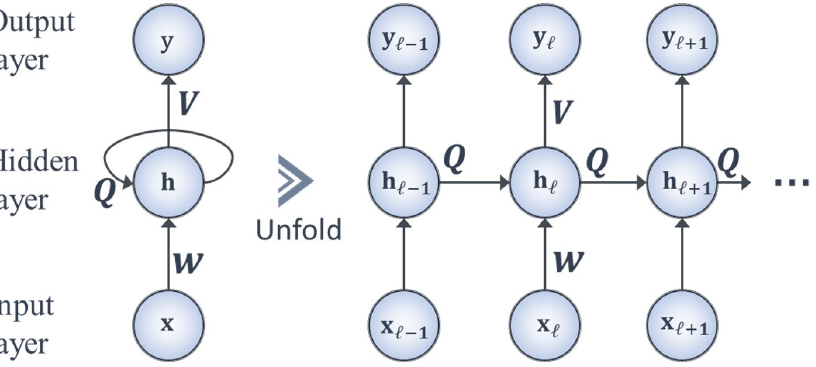
Figure 1. A schematic of a recurrent neutral network and its unfolded